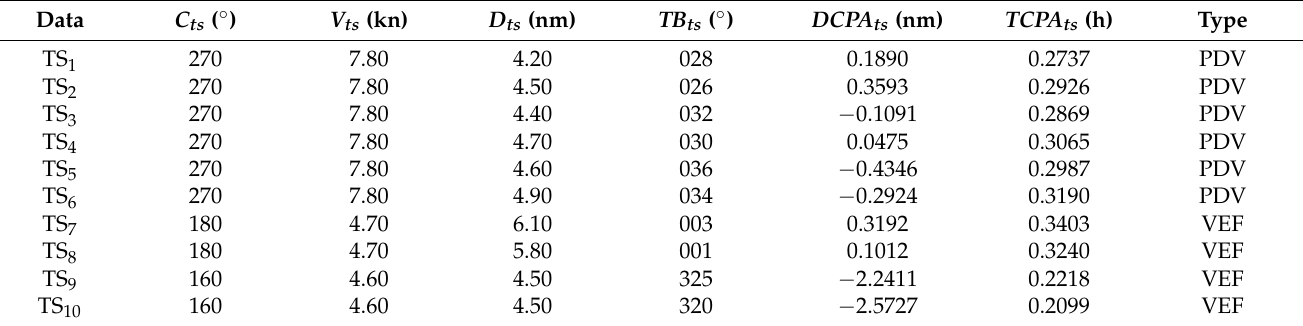
Table 3. Data of target ships at